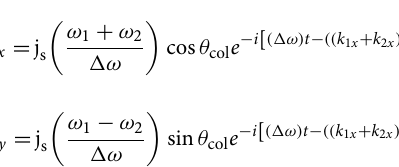
Figure 5. ( a ) Power of THz emission vs. colliding angles of the laser pulses. The power (including the contribution of non-beat-frequency components) is obtained by integrating THz intensity over y (from 32 µ m ) passing through the probe lines at x through + frequency components